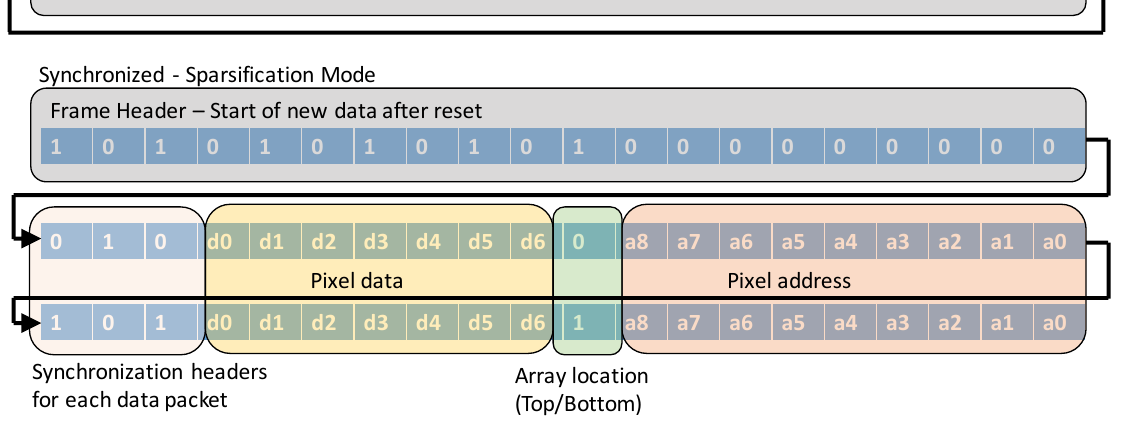
Figure 5. Synchronization pattern, frame header at the start of new data after DAQ reset and data packets with synchronization